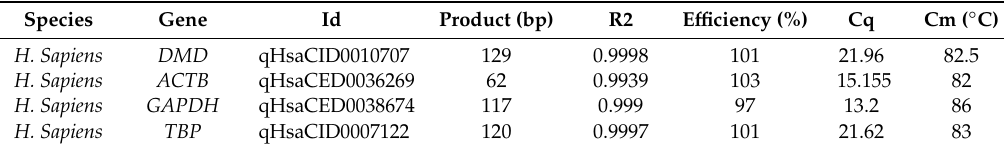
Table 3. Primers used for mRNA dystrophin